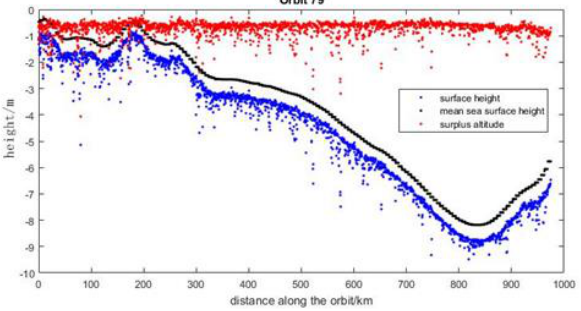
Figure 2. Surplus altitude extraction results of orbit 79